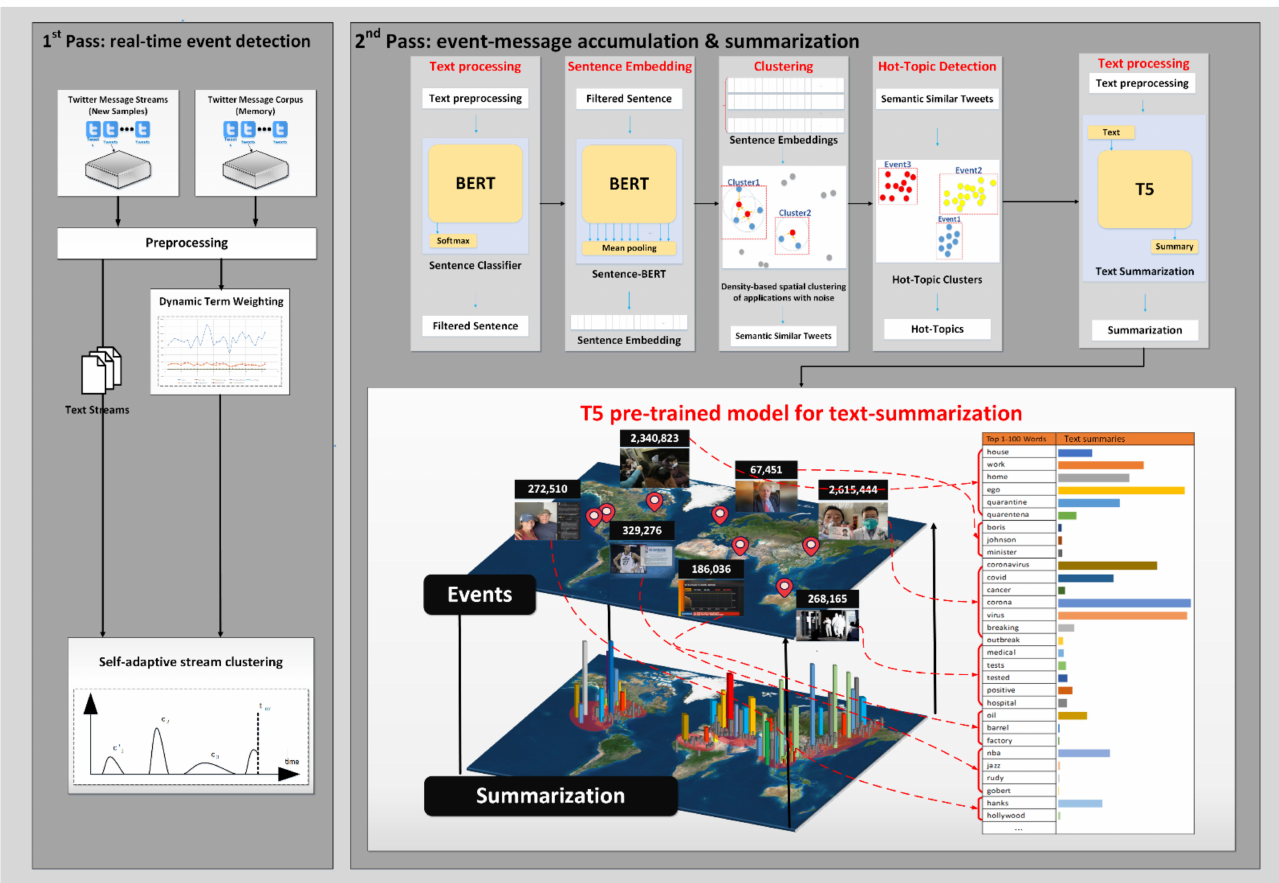
Figure 1. Proposed Twitter based real-time event summarization and pre-trained